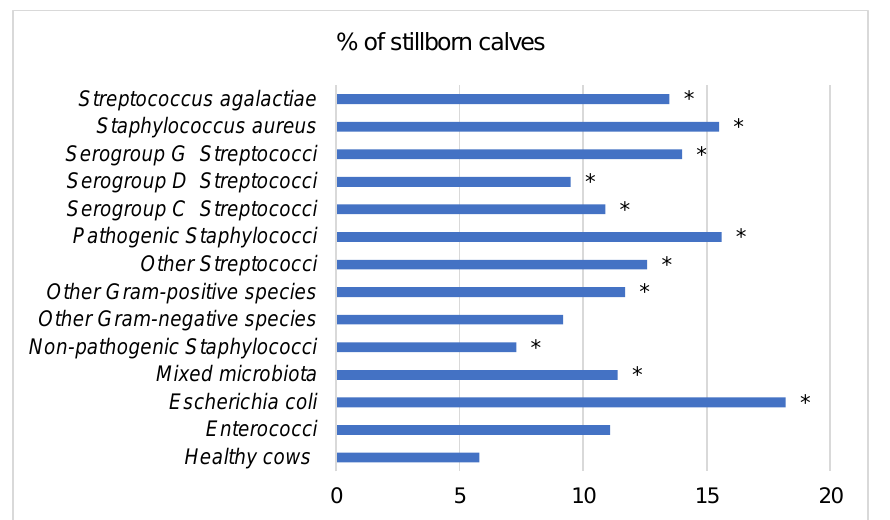
at 1.06-times. Figure 1. Percentage of stillborn calves in groups of cows. *–The difference within the group of Figure 1. Percentage of stillborn calves in groups of cows. *—The difference within the group of healthy cows is statistically significant ( p < 0.05). healthy cows is statistically significant ( p < 0.05).